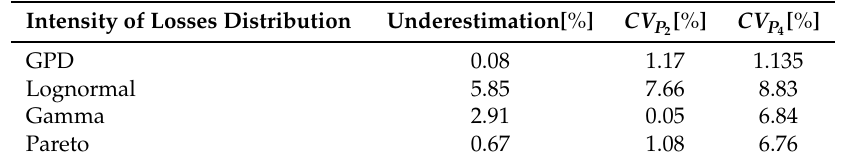
Table 7. Underestimation DP and coefficients of variation CV in percentage for the two premiums for values considered in Section 3.2 for n =